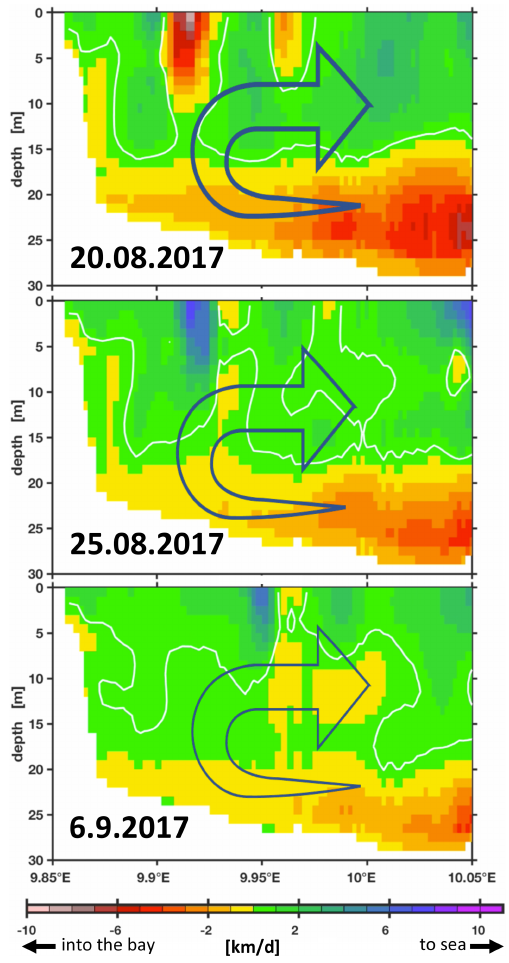
Figure 16. Simulated, daily mean zonal currents during the buildup of the 2017 hypoxic event shown in Figs. 13–15. Green to blue colors characterize flows to the east (towards the KB). Yellow to red colors indicate flows to the west (into EB). The unit is kilo- meters per day (kmd − 1 ). The depicted section has an extension of ≈ 13km. Note that the model domain extends beyond the eastern boundary shown here (see also Fig. 2).